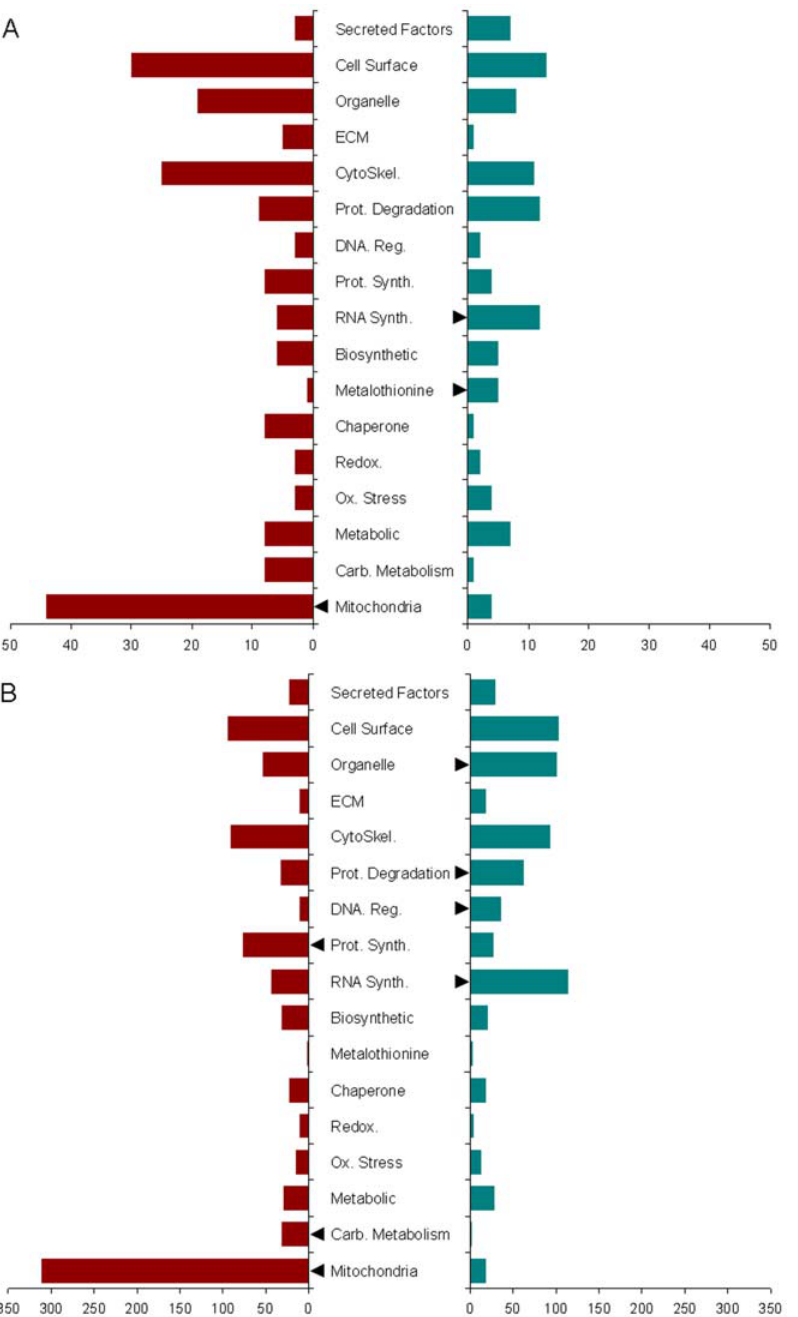
Figure 1. Early (A) and late (B) transcriptional changes during immobilization-induced muscle atrophy. (A) Two-time point comparisons of Log 2 probe signal between the PRE and 48 H time points were conducted and significant differences were assessed using standard paired T-Tests. Genes with FDR q-value , 0.05 were considered to be significantly altered. Genes were then organized along functional lines and the number of genes in each category was plotted. x 2 analyses comparing actual versus expected number of genes within each category (as detailed in the Materials and Methods) were conducted to determine whether gene categories were significantly (P # 0.05) up- or down-regulated at the early (48 H) time-point following immobilization. (B) Two-time point comparisons between PRE and 14 D probe signals were conducted as in (A) to identify gene categories that were up- or down-regulated as part of the late (14 D) transcriptional response to immobilization. Red bars are down- regulated genes whereas green bars are up-regulated genes. Arrowheads indicate gene categories that were significantly up- or down-regulated. Gene categories representing fatty acid and carbohydrate metabolism, and mitochondrial function, including oxidative phosphorylation, b -oxidation, and mitochondrial regulation, were significantly down-regulated at both 48 H and 14 D of immobilization. In addition, the gene category representing mRNA synthesis and maturation (e.g. splicing, polyadenelation, 5 9 cap binding proteins) was significantly up-regulated at both 48 H and 14 D. The gene category representing metallothioneins was up-regulated at 48 H but not 14 D, while gene categories representing proteases and DNA regulation (e.g. repair enzymes and chromatin remodeling proteins) were up-regulated at 14 D but not 48 H. Lastly, the gene category representing protein synthesis was down-regulated at 14 D but not at 48 H. ECM: extracellular matrix; Prot. Degradation: protein degradation; DNA. Reg.: DNA regulatory factors; RNA Synth.: RNA synthesis and maturation; Ox. Stress: oxidative stress; Carb. Metabolism: carbohydrate metabolism.